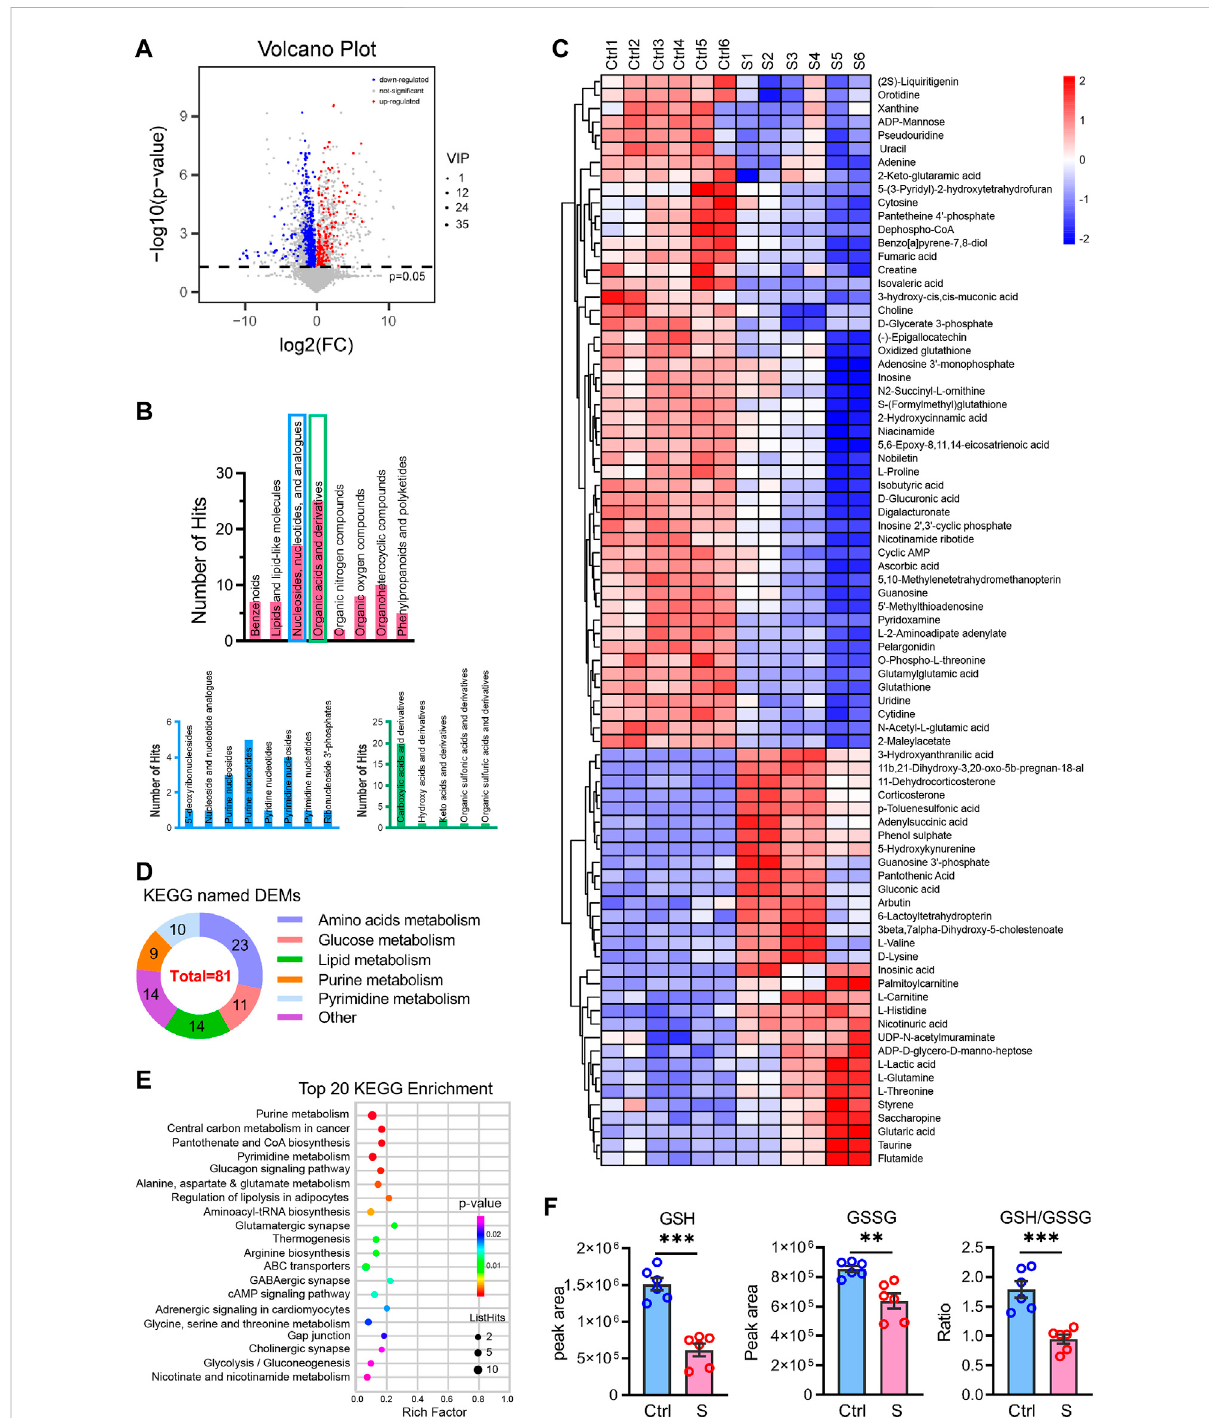
FIGURE 3 Differentially expressed metabolites pro fi ling the hippocampus in the SAE (S) and control groups (Ctrl). (A) Volcano plot showing differentially expressed metabolites (DEMs) pro fi ling of hippocampus between the S and the Ctrl group, the red and blue bubble showed the up- and downregulated metabolites, respectively. (B) The classes of differential expressed metabolites in the SAE-grouped hippocampus. (C) The heatmap showedtherelativecontentsofDEMs.S1 – S6,thesepsisgroup;Ctrl1 – 6,thecontrolgroup. (D) TheclassesofmetabolismofDEMsintheKEGG ( n = 3). (E) The top 20 KEGG enrichment items of DEMs. (F) The peak area of GSH and GSSG, and the ratio of GSH/GSSG, Statistic comparisons were performed by unpaired t-test. Data are presented as mean ± SEM ( n = 6), *p < 0.05, **p <